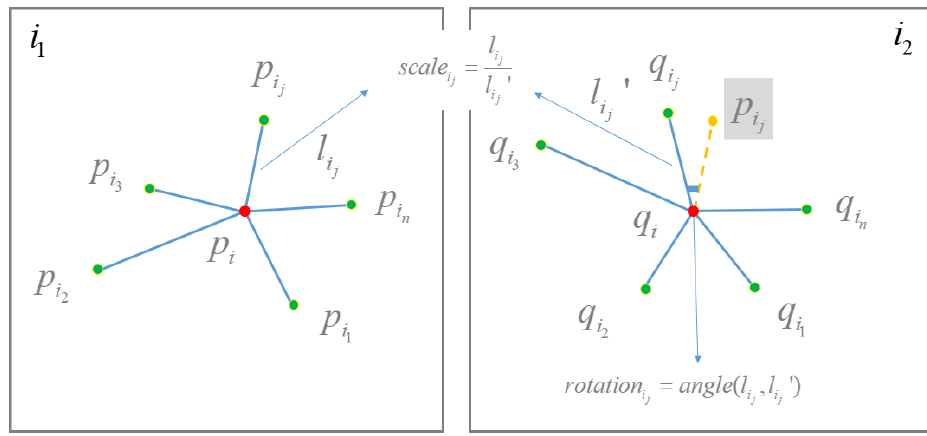
Figure 3. The illustration of the SOV geometric